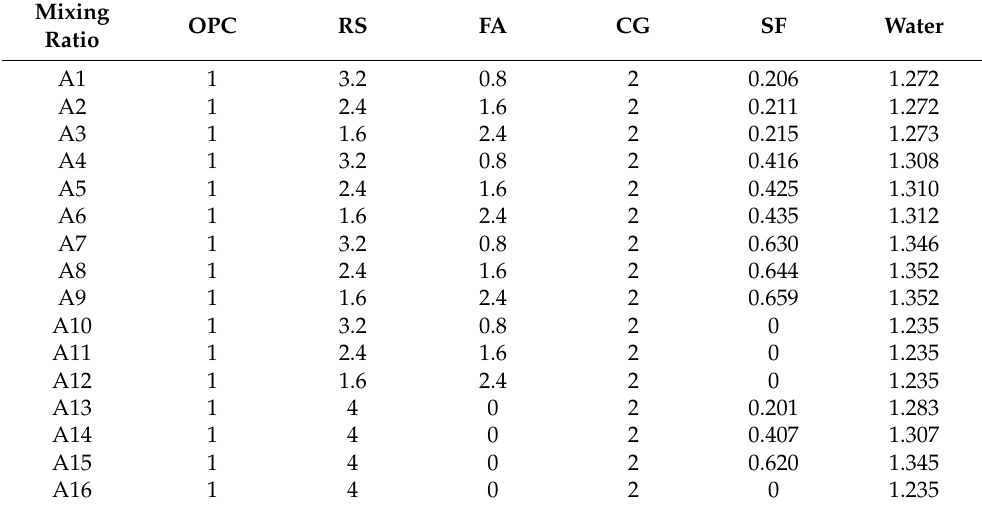
Table 4. Experimental scheme